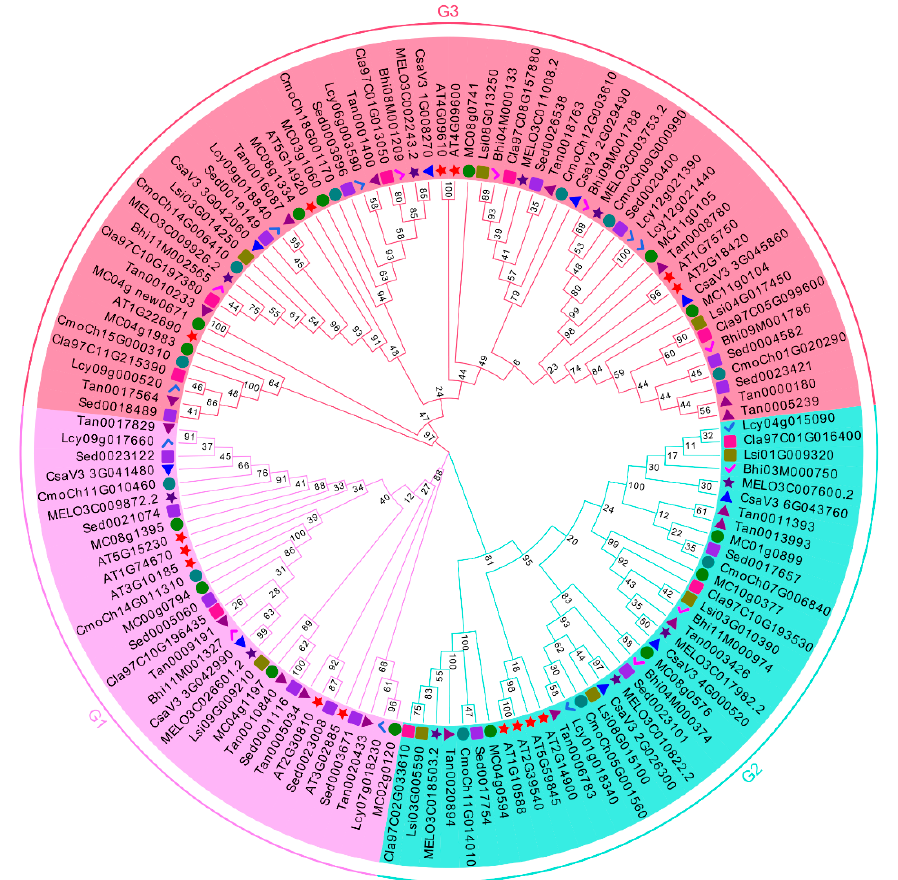
Figure 1. The phylogenetic tree of GASA proteins from Arabidopsis and 10 Cucurbitaceae species .